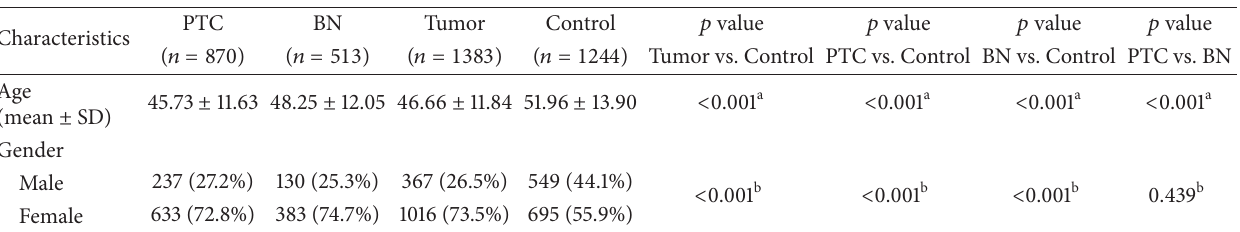
Table 1: The age and gender distribution of the papillary thyroid cancer (PTC), benign thyroid tumor (BN), and control groups.